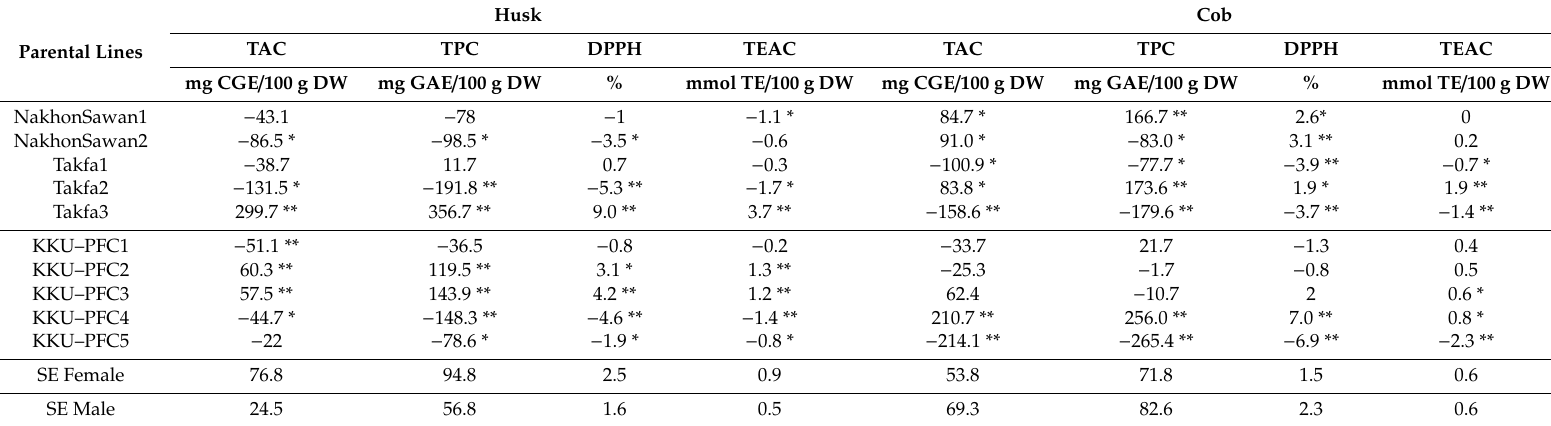
Table 5. General combining ability e ff ects (GCA) for total anthocyanin content (TAC), total phenolic content (TPC), and antioxidant activity determined by DPPH and TEAC method of parents across two locations.